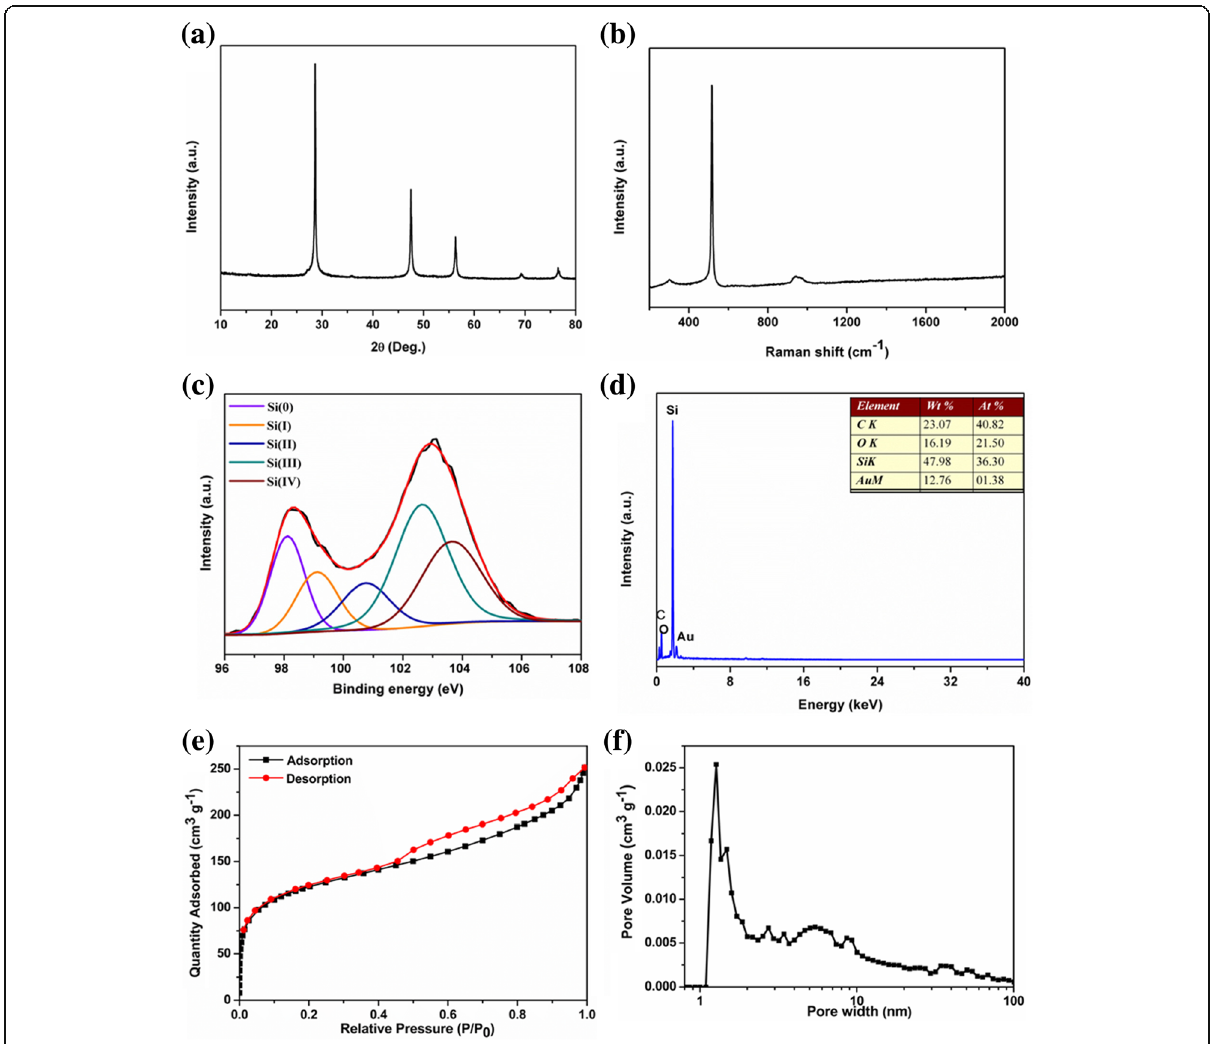
Fig. 1 a PXRD patterns, b Raman spectra, c XPS spectrum, d EDS spectrum, e nitrogen adsorption-desorption curves, and f the pore size distribution curve of